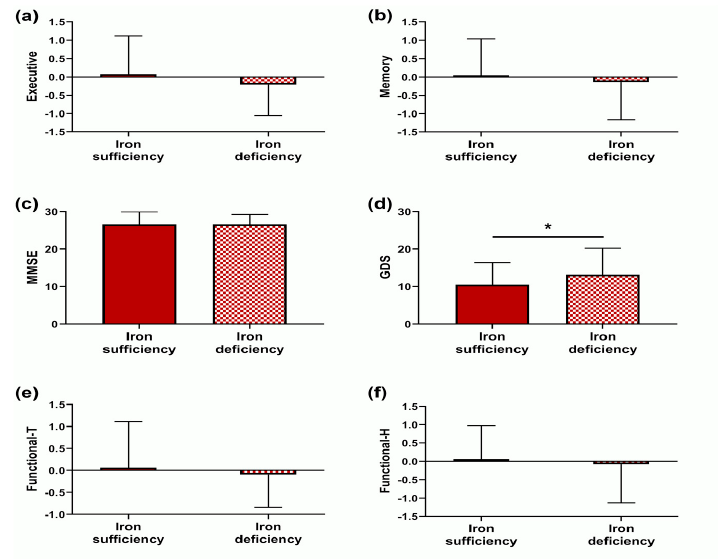
Figure 2. Cognition, mood and physical functional ability comparison between iron sufficient and iron deficient participants. ( a ) Executive dimension (z-score); ( b ) Memory dimension (z-score); ( c ) mini-mental state examination (MMSE) score; ( d ) Geriatric depression scale (GDS) score; ( e ) Functional tiredness dimension (z-score); ( f ) Functional help dimension (z-score). * p < 0.05. Similarly, two dimensions were obtained from the subscales of the QoFA: (i) functional-T dimension (functional tiredness, Cronbach’s alpha: 0.763), composed by mobility tiredness, lower limb tiredness and upper limb tiredness subscales; and (ii) functional-H dimension (functional help, Cronbach’s alpha: 0.690), composed by mobility help and PADL help. Like the variables of origin, higher scores represent higher functionality, so higher scores on functional-T represent less tiredness